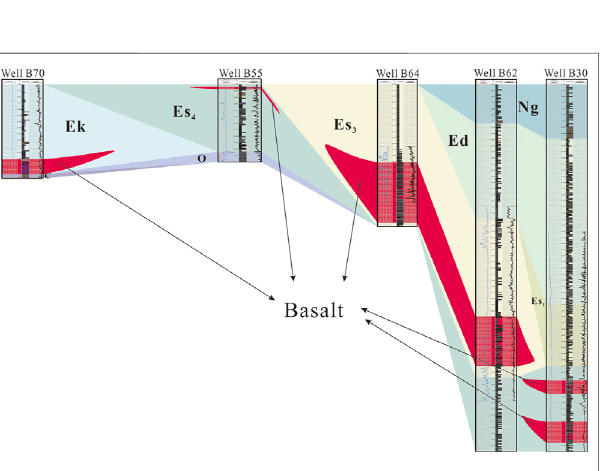
Frontiers in Earth Science |